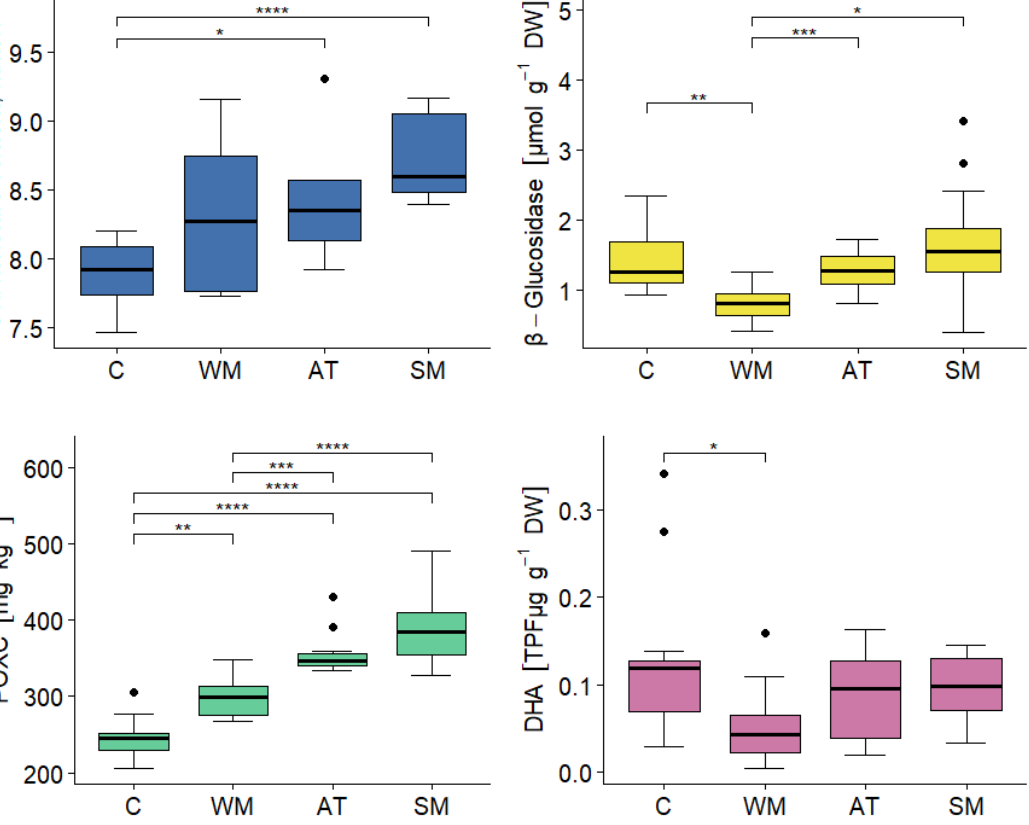
Figure 3. Summary of four measured soil variables at the Serbian site, with box and whisker plots indicating outliers and variations outside the lower and upper quartiles, as distinguished by the effect of the treatment: C: control; WM: wool mulch; AT: agro textile; SM: straw mulch. The results of the multiple comparisons of the UNIANOVA model are indicated by the lines above the graph.